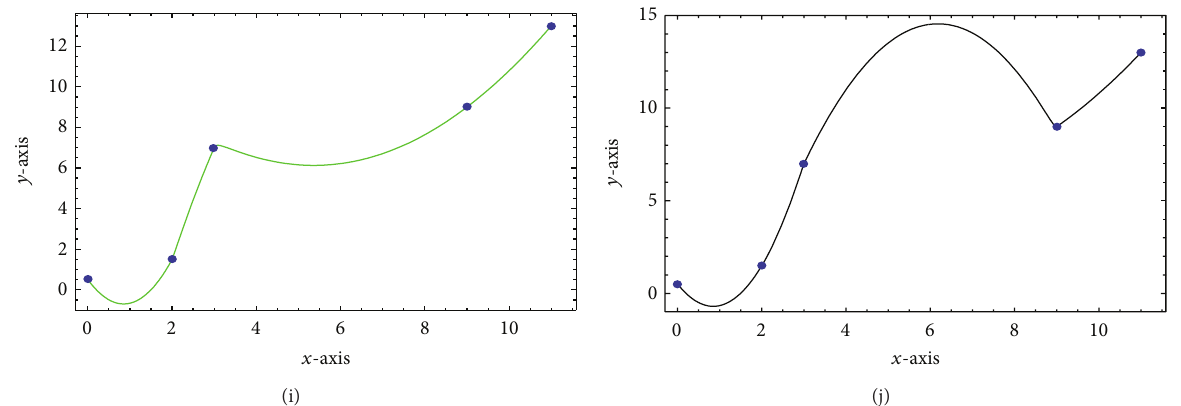
Figure 2: Shape control of rational cubic interpolating curves with various values of shape parameters list in Table 2.